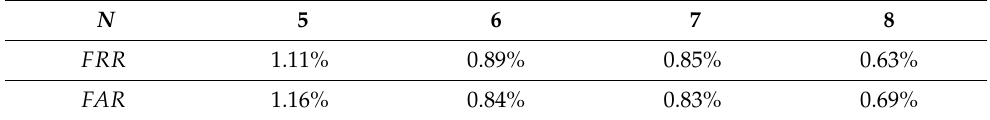
Table 3. Experimental results when MinPts = 2 and (cid:101) =